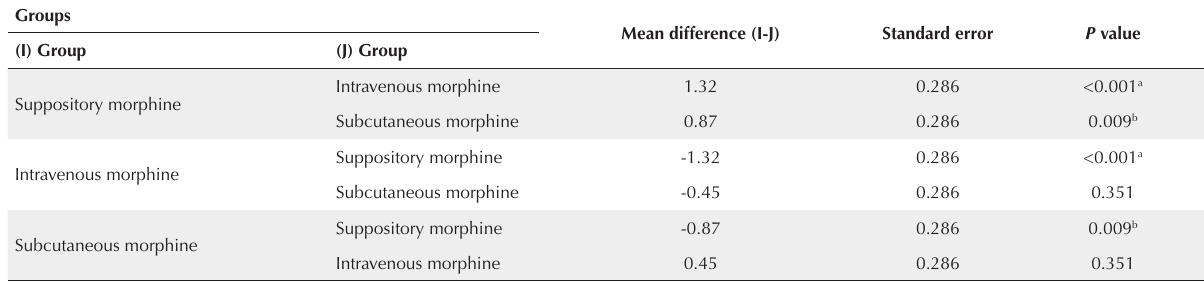
Table 2. Comparison of postoperative pain intensity among the studied groups Groups